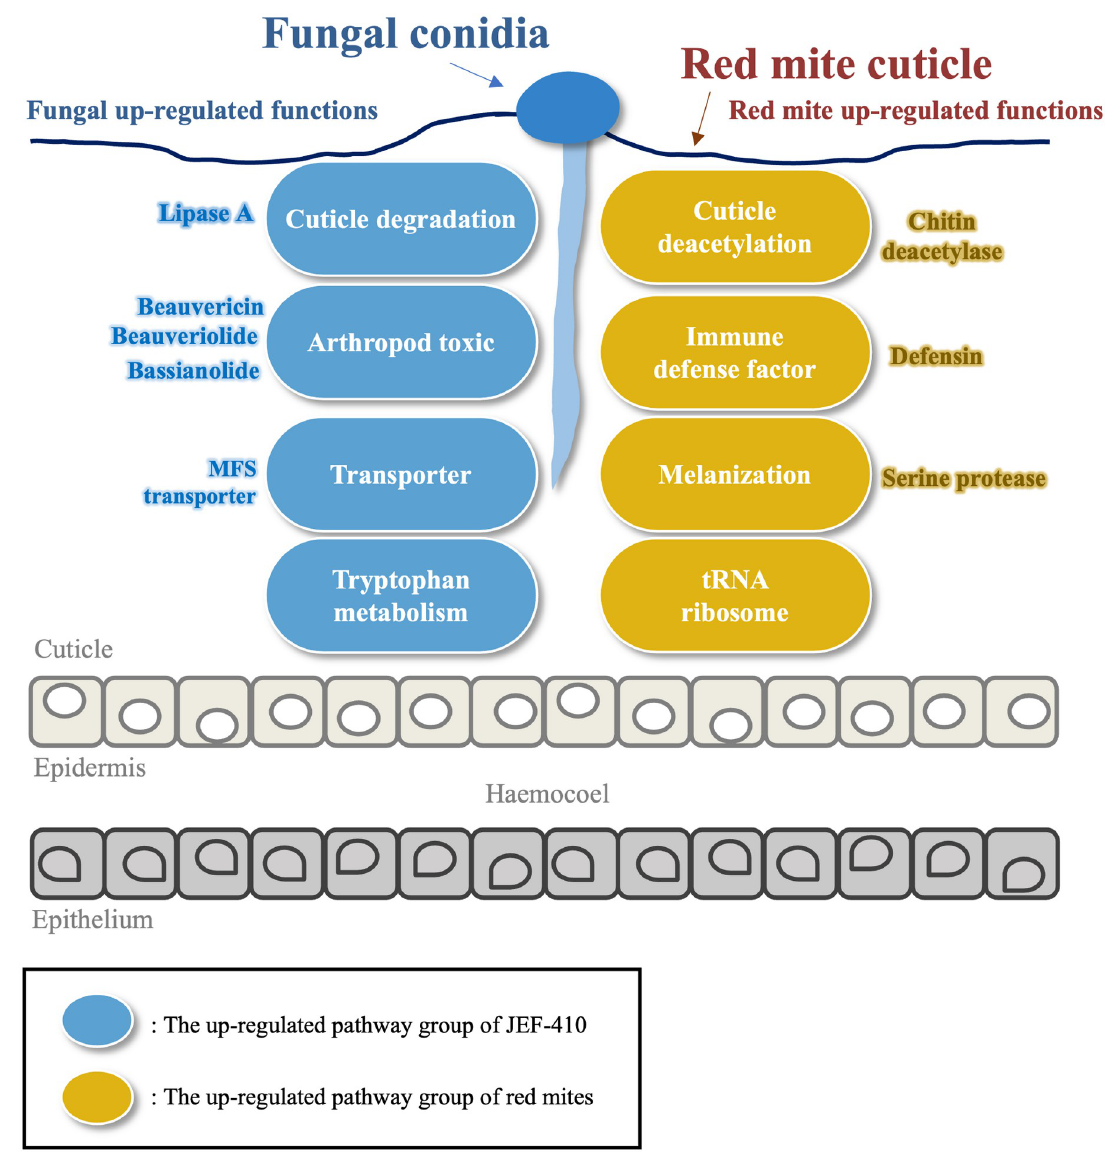
Fig 8. Interaction of B . bassiana JEF-410 and red mite at early stage of infection.